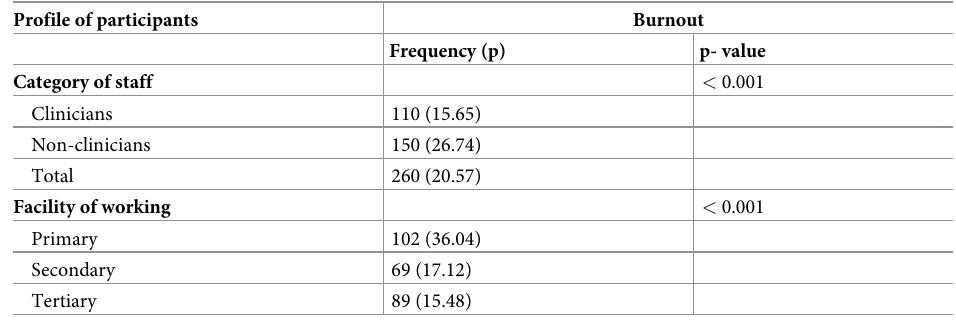
Table 3. Prevalence of burnout among participants.